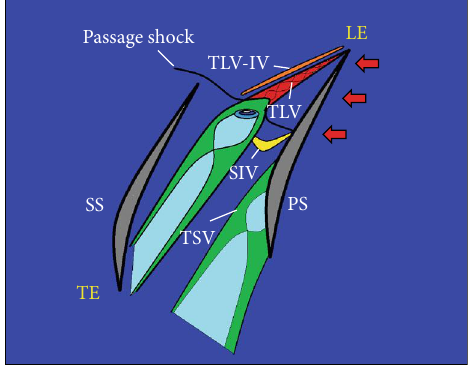
Figure 17: Schematic representation of tip vortex